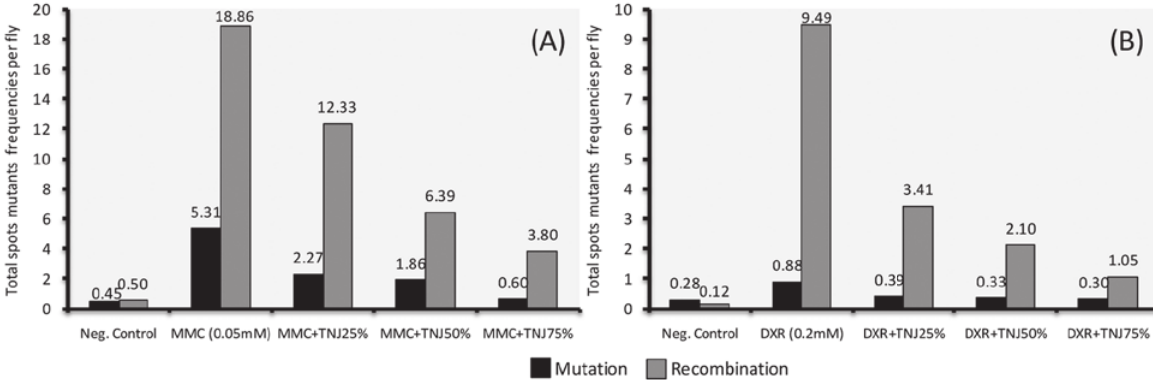
Figure 1 - Contribution of mutation and recombination to total mutant spots frequencies per fl y in trans-heterozygous fl ies treated with MMC (A) or DXR (B) in combination with TNJ (25%, 50%, 75%). The recombinagenic action was calculated according to Graf et al. (1992) and Sinigaglia et al. (2006) as follows: Frequencies ( F Graf et al. (1992) and Sinigaglia et al. (2006) as follows: Frequencies ( F Graf et al. (1992) and Sinigaglia et al. (2006) as follows: Frequencies ( ) = total F ) = total F mwh clones (n) /number of fl ies (N); Mutation Frequencies ( F Frequencies ( F Frequencies ( M) = frequencies of F M) = frequencies of F mwh clones in balancer-heterozygous/frequencies of mwh clones in marker trans-heterozygous; Recombination Frequencies ( F R) = 1- F R) = 1- F FM ; Frequencies of Total Spots ( FM ; Frequencies of Total Spots ( FM F T) = total spots in F T) = total spots in F mwh / fl r / fl r / 3 fl ies (considering mwh and fl r 3 spots)/number of fl ies; Mutation = F T × F T × F F M; Recombination = F M; Recombination = F F T × F T × F F R. F R.